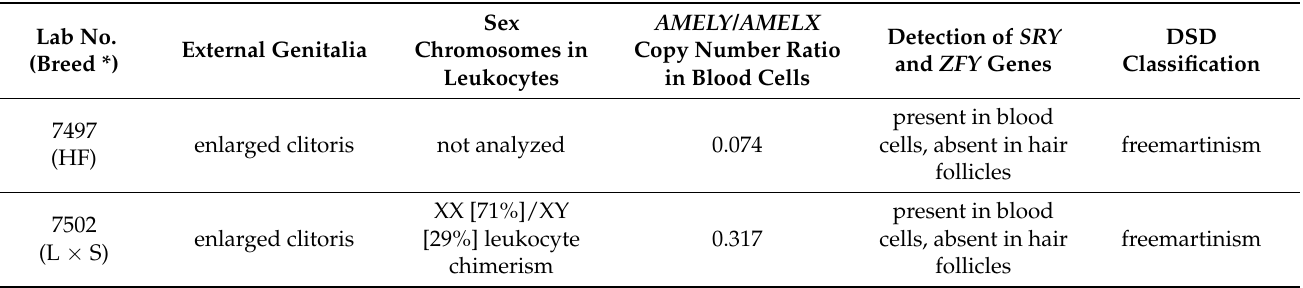
Figure 1. Virilized external genitalia of studied cases. ( a ) Case #7497. ( b ) Case #7502. ( c ) Case #7515. ( d ) Case #7518. ( e , f ) Case #7514. Table 1. Phenotypes and classification of DSD